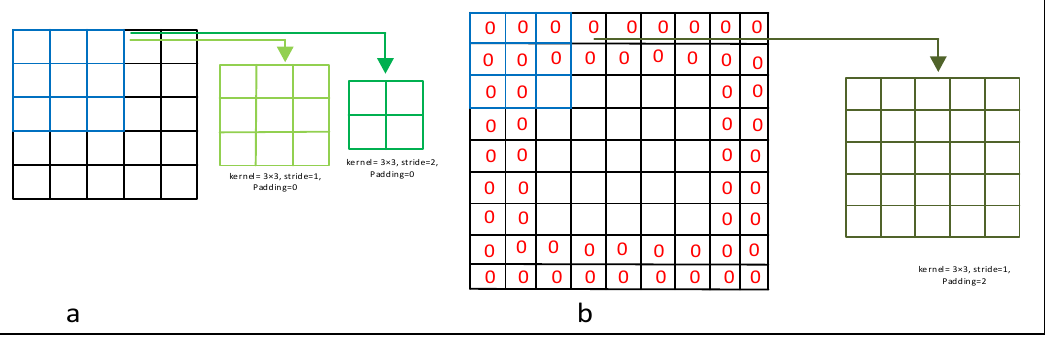
Figure 6. This figure represents the effects of kernel size, the size stride and zero padding in a convolutional